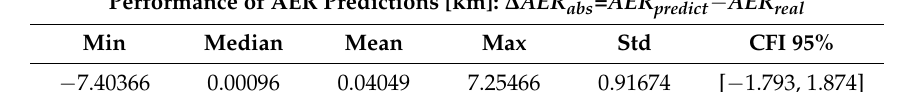
Table 5. Basic statistical indicators of AER predictions for CNN-based model.